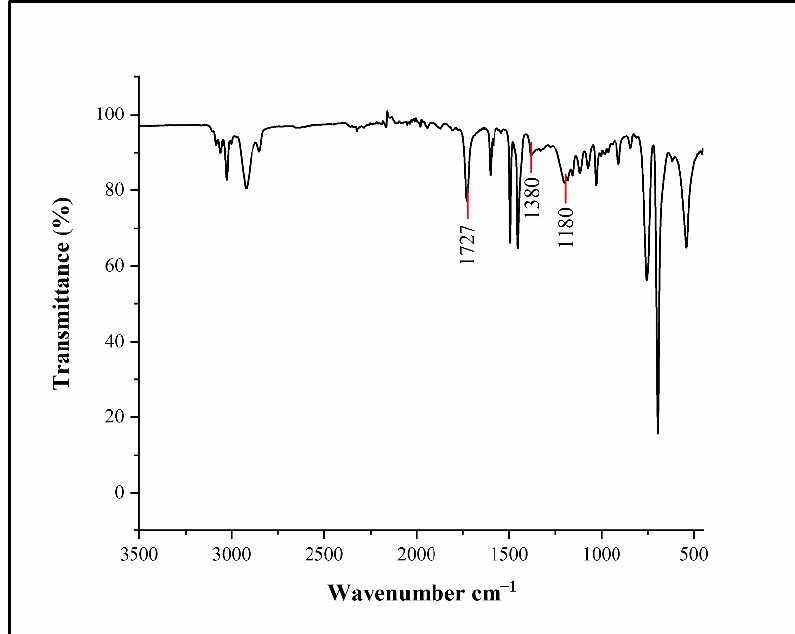
Figure 3. FT-IR spectroscopy of p-toluenesulfonyl modified PS microspheres.